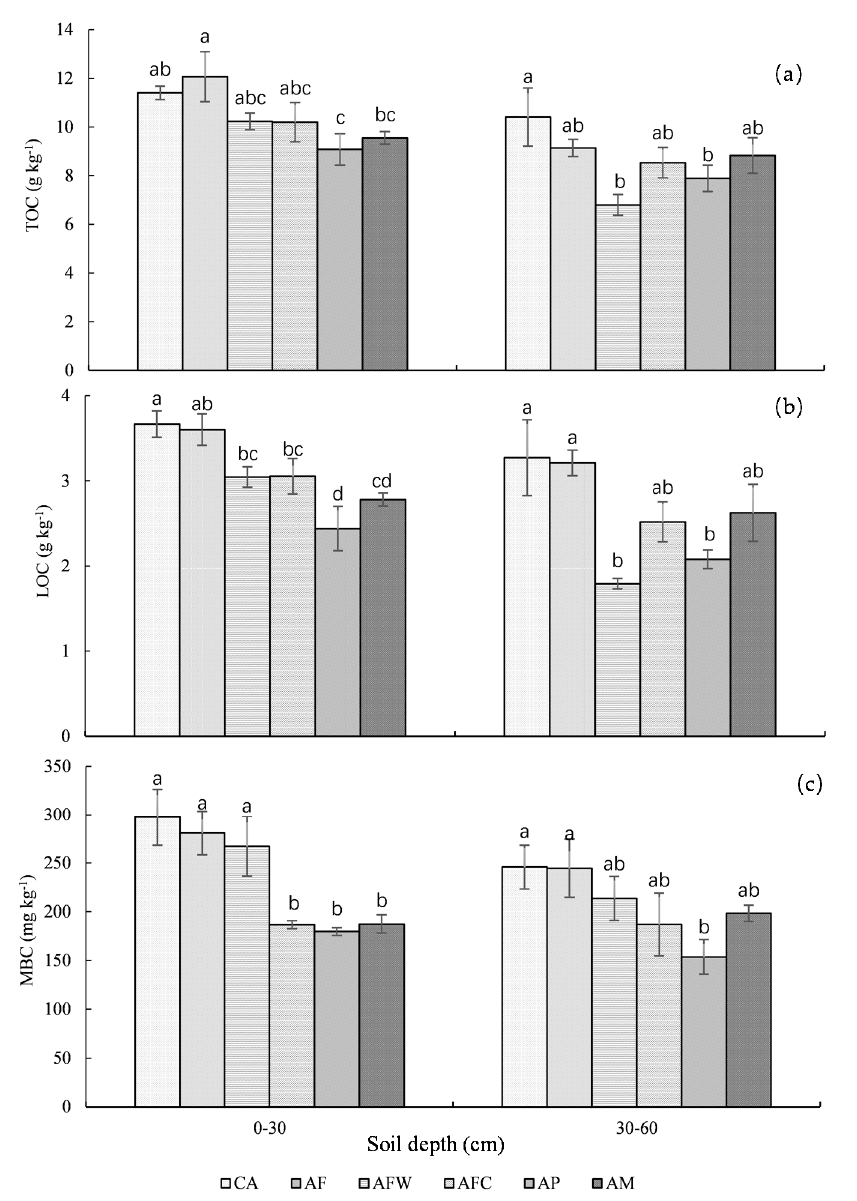
Figure 1. Soil organic carbon content at two soil depths in different cropping systems: ( a ) Soil total organic carbon (TOC); ( b ) Soil labile organic carbon (LOC); and ( c ) Soil microbial biomass carbon (MBC). Continuous alfalfa (CA), alfalfa-fallow (AF), alfalfa-fallow-wheat (AFW), alfalfa-fallow-maize (AFC), alfalfa-potato (AP), alfalfa-millet (AM). Error bars with different letters within a same soil depth indicate a significant difference at p < 0.05.